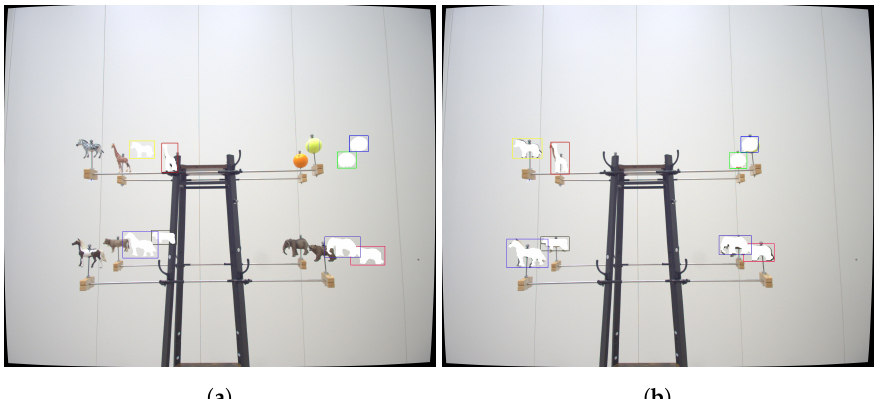
Figure 9. Comparison of the annotation quality for an image annotated using different extrinsic cali- brations. ( a ) (Manual extrinsic calibration) shows the annotation result using a manually determined extrinsic calibration between camera image plane and camera tracking rigid body. Given the marker configuration from Figure 4a, we manually measured the transformation from the pivot marker to the assumed position of the image sensor. In ( b ) (Optimized extrinsic calibration), the results are presented for the extrinsic calibration determined by solving the optimization problem. In general, determining the correct extrinsic calibration between rigid body and image plane greatly improves the annotation quality. Best viewed as PDF and in